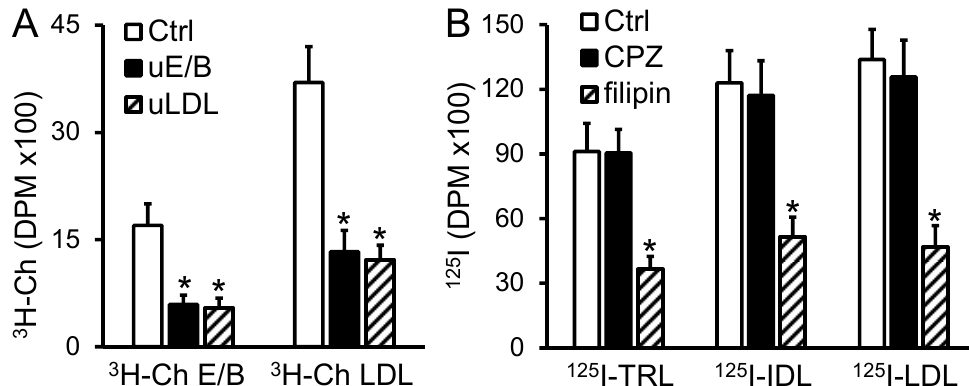
Figure 1. Transendothelial transport of radiolabeled apoB-LPs is inhibited by filipin and unlabeled competitor lipoproteins. ( A ): The AP side of the MAEC monolayer was incubated with 20 µg/mL (35,000 DPM) of 3 H-Ch-labeled E/B-LPs ( 3 H-Ch E/B) or 3 H-Ch-labeled LDLs ( 3 H-Ch LDL) in the presence of 800 µg/mL of unlabeled E/B-LPs (uE/B) or unlabeled LDLs (uLDLs) or in the absence of unlabeled lipoproteins as a control (Ctrl) for 24 h. ( B ): The AP side of the MAEC monolayer was pre-incubated with 20 µg/mL chlorpromazine, 5 µg/mL filipin, or 1 µL/mL dimethyl sulfoxide as a Ctrl for 1 h, followed by incubation with 20 µg/mL (167,000 DPM) of 125 I-labeled TRLs, IDLs, or LDLs for 24 h. The radioactivity in the BL medium were counted. Values represent the mean ± SE of 3–5 experiments; * p < 0.05 vs. Ctrl.